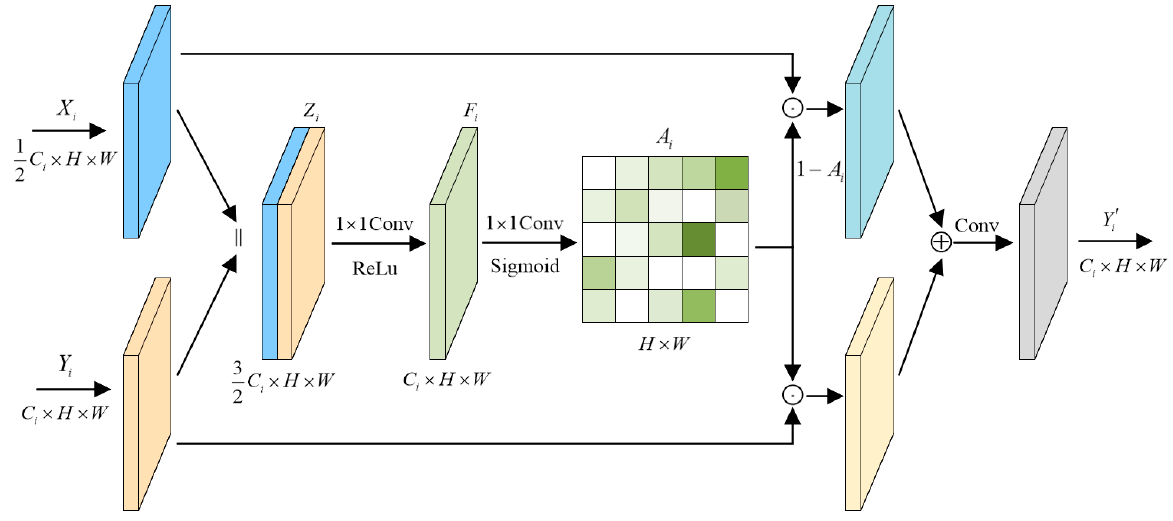
Figure 4. The Edge Attention Block